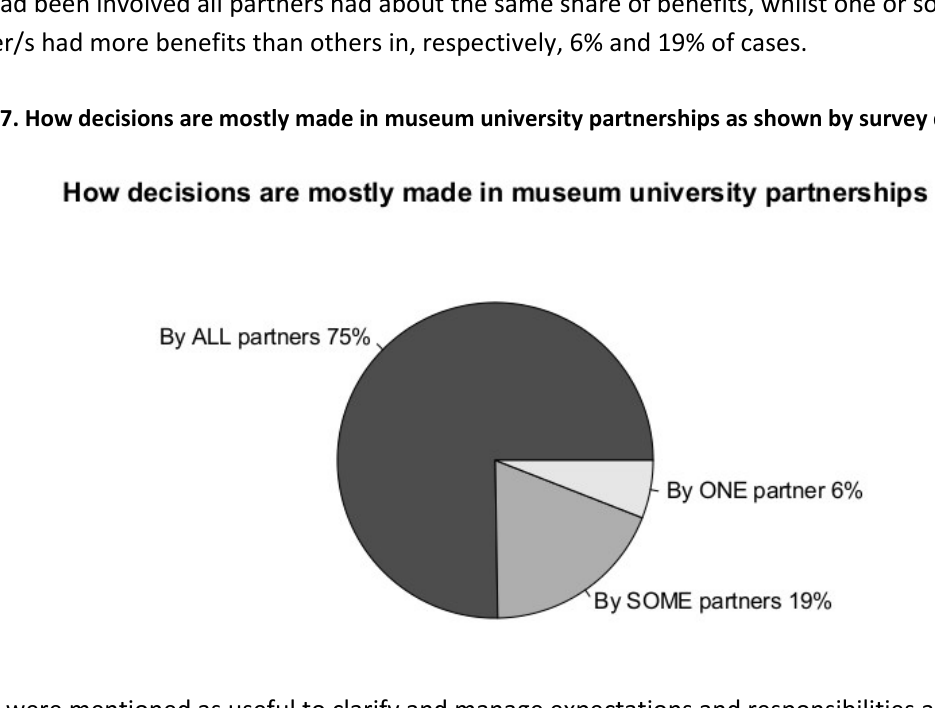
Figure 7. How decisions are mostly made in museum university partnerships as shown by survey